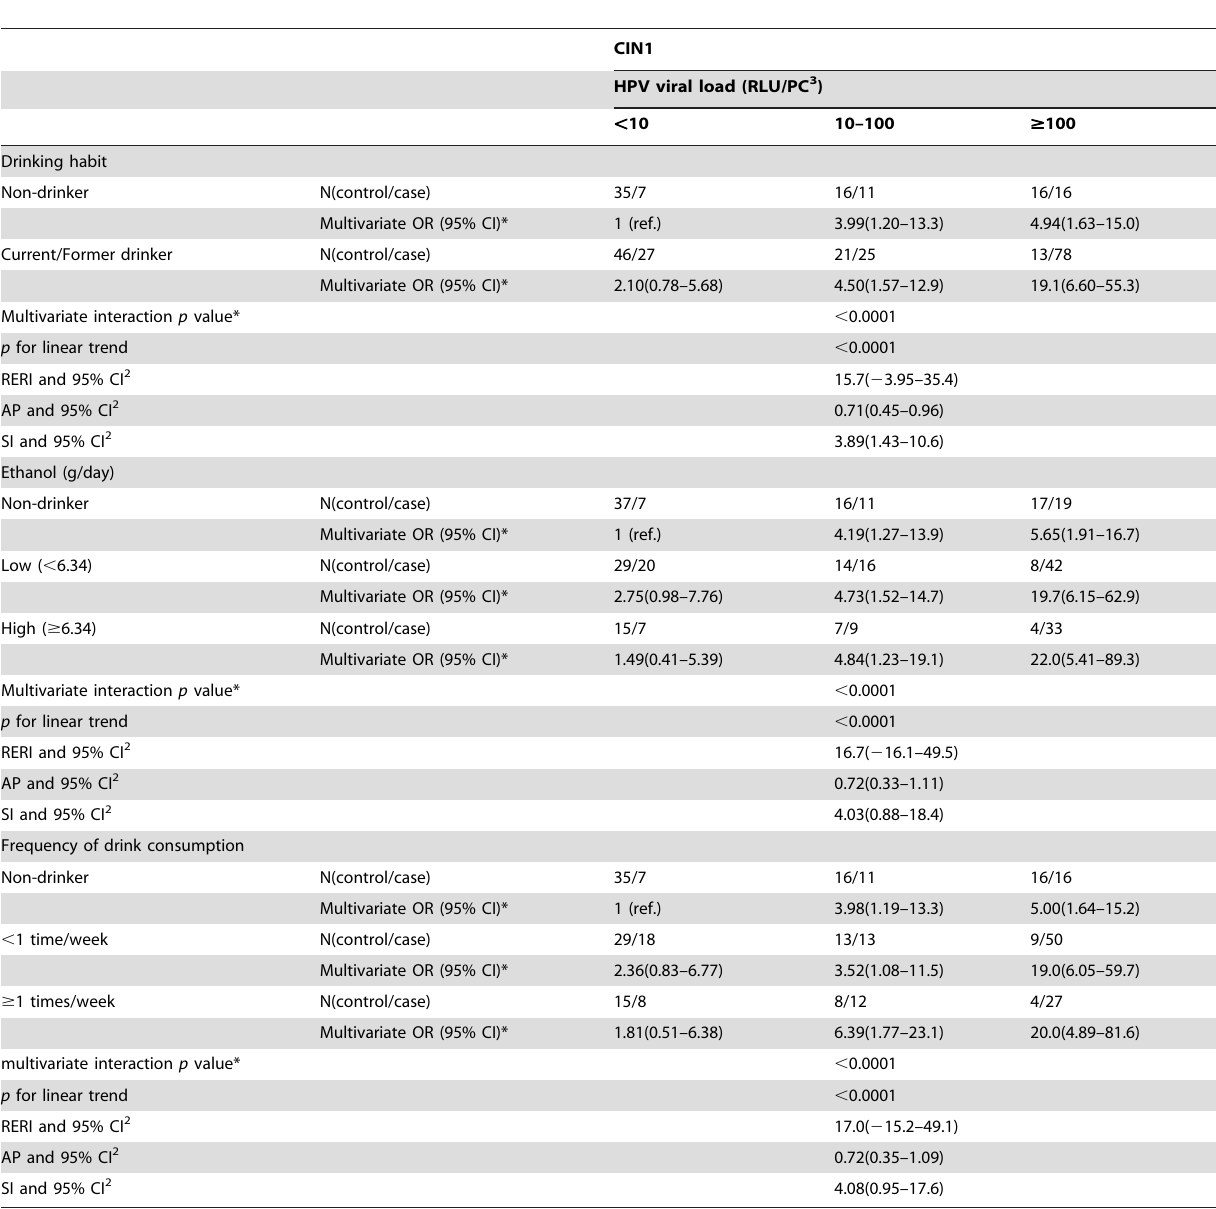
Table 3. Combined effects of alcohol drinking and HPV viral load on the risk of CIN1 in HPV-positive